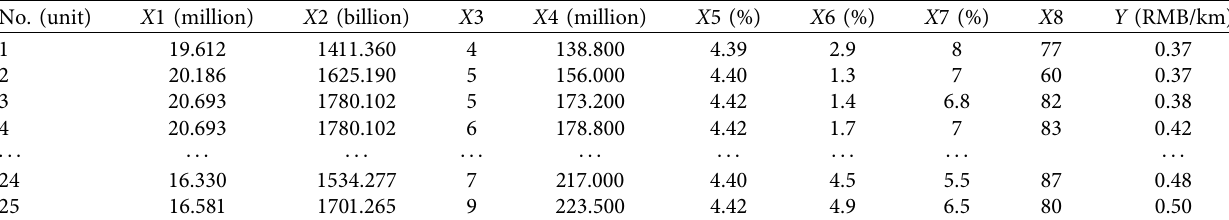
Table 2: Engineering data.